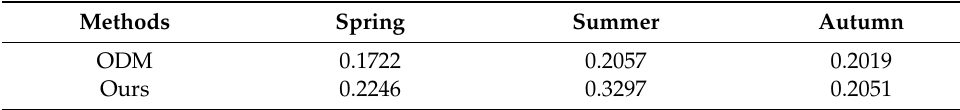
Table 3. SSIM values of two methods on color aerial image